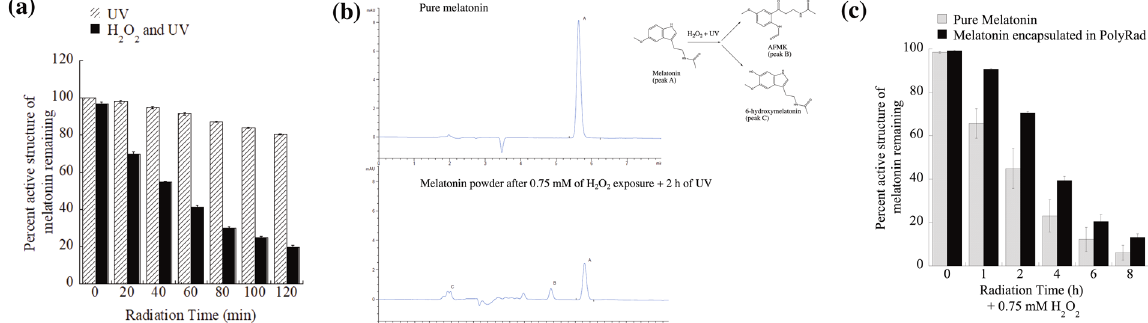
Figure 6. PolyRad protects melatonin from photochemical degradation. ( a ) 2.5 μ g melatonin was spiked with 0.75 mM H 2 O 2 followed by UV irradiation (254 nm) every 20 min for 2 h. Samples were freeze-dried, dissolved in 1 ml of 40% acetonitrile-60% water and analyzed using HPLC. The column graphs show the percent active structure of melatonin remaining after UV radiation only (hatched, open columns) and after H 2 O 2 and UV treatments (black, filled columns). (b) The changes in melatonin peak areas after H 2 O 2 and UV treatments. (c) PolyRad (black columns) was exposed to 0.75 mM H 2 O 2 and UV treatments for longer exposure time for up to 8 h to find what percentage of melatonin is protected by PolyRad compared to bare melatonin (hatched columns). The columns represent mean of n = 3 and error bars denote standard deviation (SD).